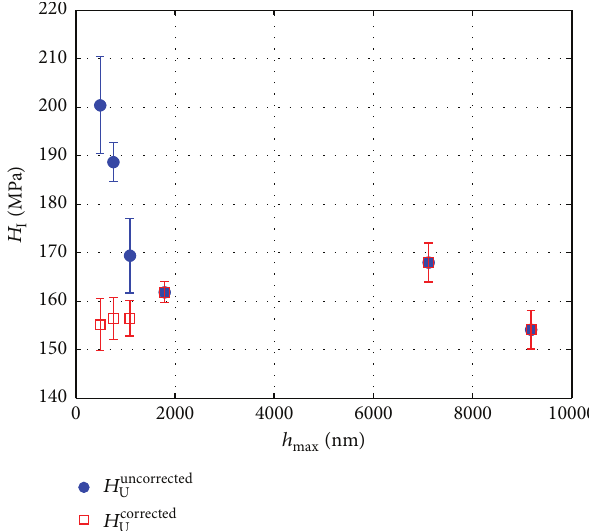
Figure 20: Indentation hardness of glassy poly(ethylene terephtha- late) (PET) obtained with a Vicker tip ( 𝐻 corrected I and 𝐻 uncorrected I representtheindentationhardnesswithandwithoutconsideringthe effect of tip bluntness, resp.) where a holding period of 6 s was used at the maximum applied force [61].